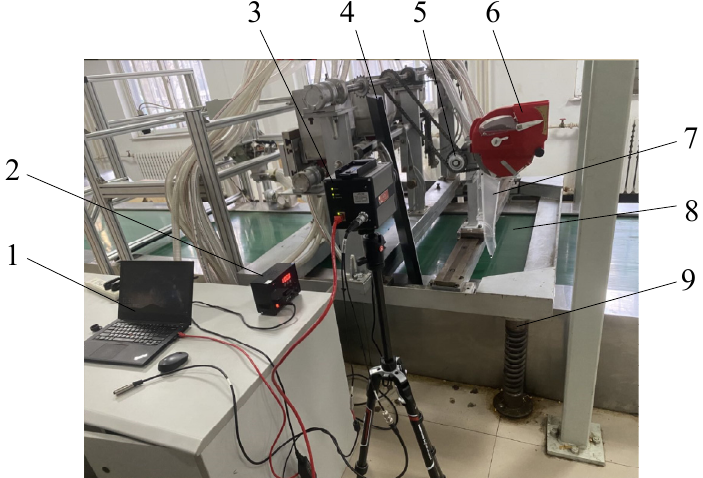
Figure 9. Test bench: 1. computer, 2. light source controller, 3. L-PRI 1000 high-speed camera (produced by AOS Technologies AG, with a frame rate of 500 frames per second during the test), 4. light